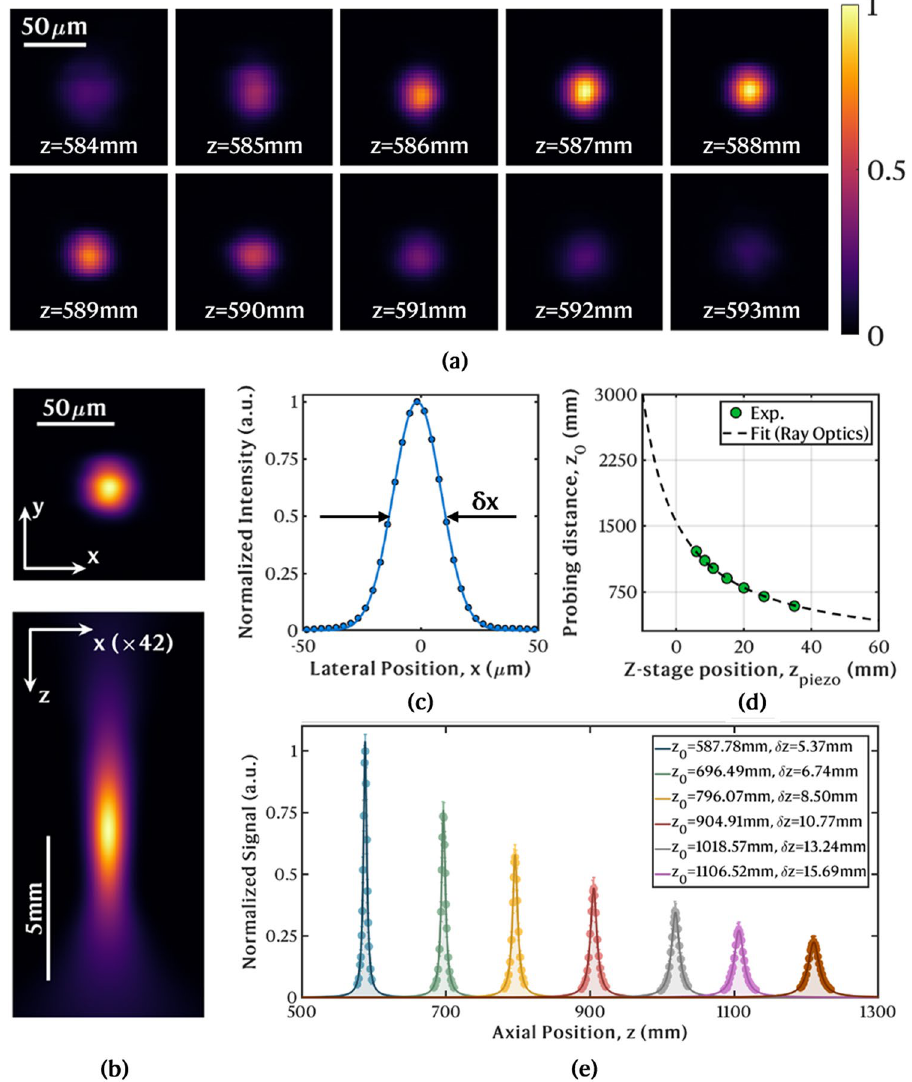
Figure 2. Experimental resolution measurements. ( a ) Montage of the obtained underwater images of an individual 22–27 μm fluorescent microsphere at several z-positions along the excitation probe focused at z 0 ∼ 587 mm. Each image has 80 × 80 16-bit pixels acquired with dwell time of 4.44 μs. ( b ) Transverse ( xy ) and axial ( xz ) normalized PSF. For the sake of representation alone, a gridded interpolation was applied (cubic spline in xy ; Lorentzian interpolant in z ). ( c ) Associated integrated intensity profile along x and respective Gaussian fit with FWHM δ x ∼ 23.93 μm. ( d ) Probing distance, z 0 , as a function of the L 1 z-stage position z piezo , and imaging described by Eq. (1) using ray optics. ( e ) Deconvolved axial weighting functions at different z 0 with Lorentzian fitting curves normalized to the closest